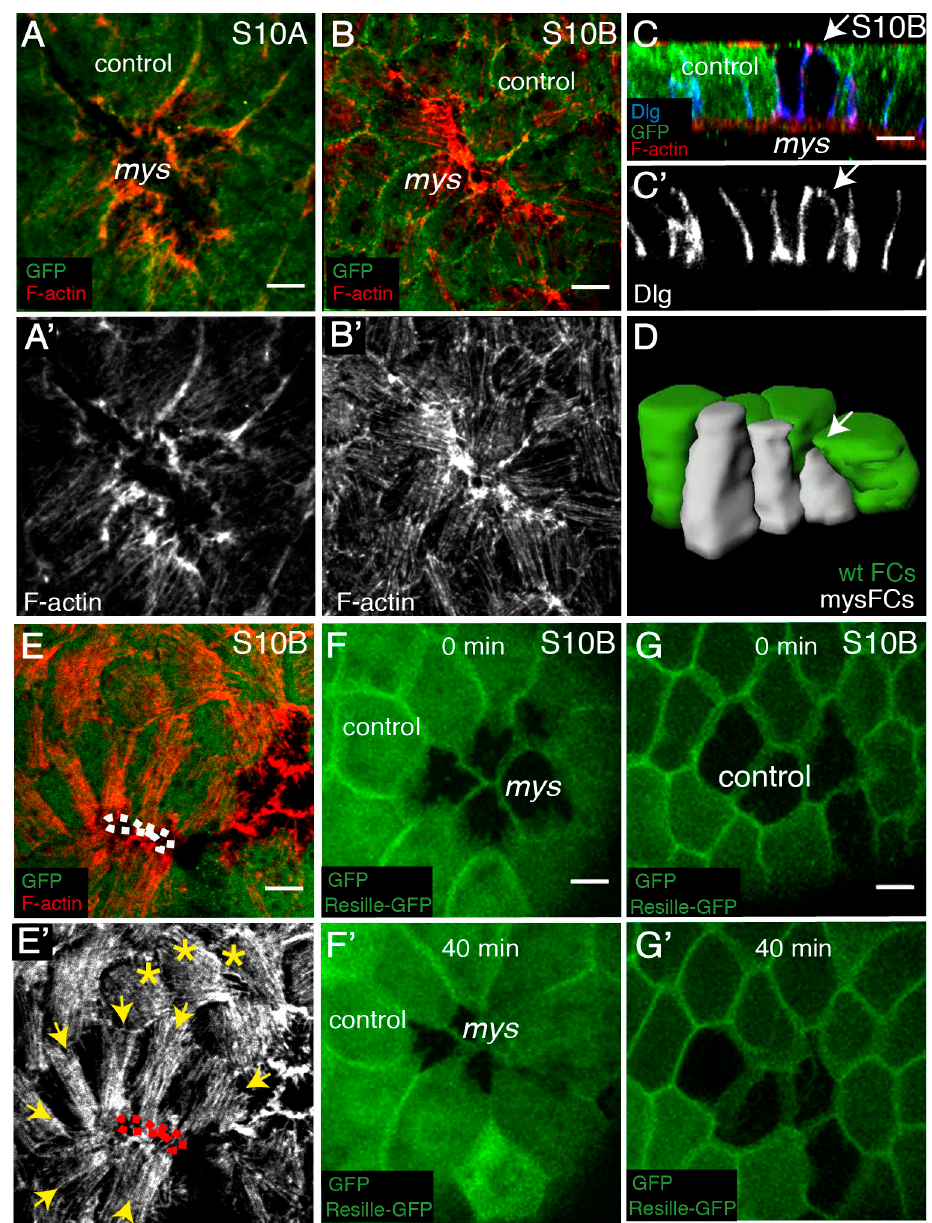
Fig 6. Elimination of integrin in FCs disrupts cytoskeletal organisation in neighbouring control cells. (A, B) Basal surface view of S10A (A, A’) and S10B (B, B’) mosaic follicular epithelia containing mys FC clones (GFP-negative), stained with anti-GFP (green) and Rhodamine Phalloidin to detect F-actin (red). (C) Lateral view of a S10 mosaic egg chamber stained with anti-GFP (green), Rhodamine Phalloidin (red) and anti-Dlg (basolateral polarity marker Discs large, blue). (D) 3D reconstruction of mys FCs and surrounding control cells. Arrows in C and D point to the basal surface of a mutant FC. (E, E’) Basal surface view of a S10B mosaic FE containing mys FC clones (GFP-negative). Yellow arrows and asterisks mark control FCs contacting control and mys FCs, respectively. (F-G’) Confocal images of live S10B mosaic egg chambers containing mys ( F ) or GFP ( G ) clones and expressing the cell membrane marker Resille-GFP. Images were taken with a 40 minutes interval. Scale bars, 5 μ